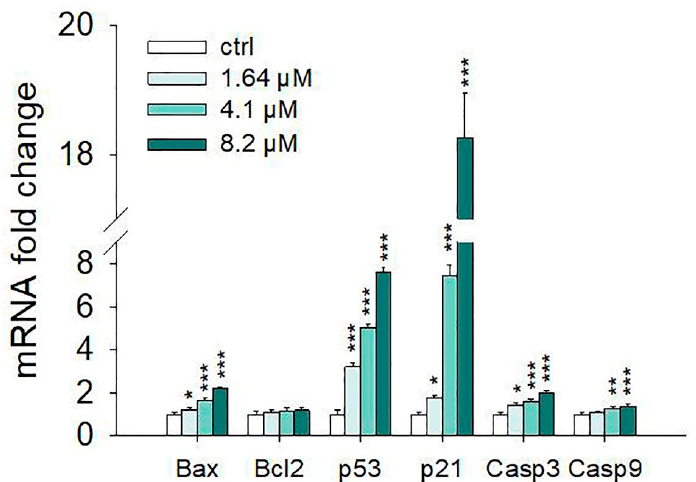
Figure 7. Effects of moringin on mRNA levels of apoptosis-related genes. SH-SY5Y cells were exposed to 1.64–8.2 µM of moringin for 24 h and then subjected to Real-Time PCR. Relative quantities of mRNA were calculated by using the 2 – ΔΔ CT method. Results are expressed as fold change relative to untreated cells. Data, expressed as mean ± SEM, represent the values obtained in three different sets of experiments made in triplicate. * p < 0.05, ** p < 0.01, and *** p < 0.001 vs. control, respectively.